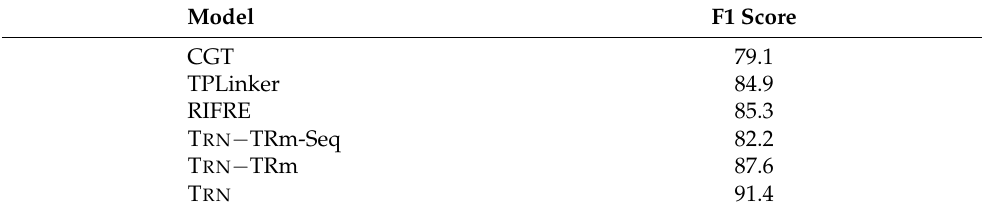
Table 5. Performance of different models on our subset.